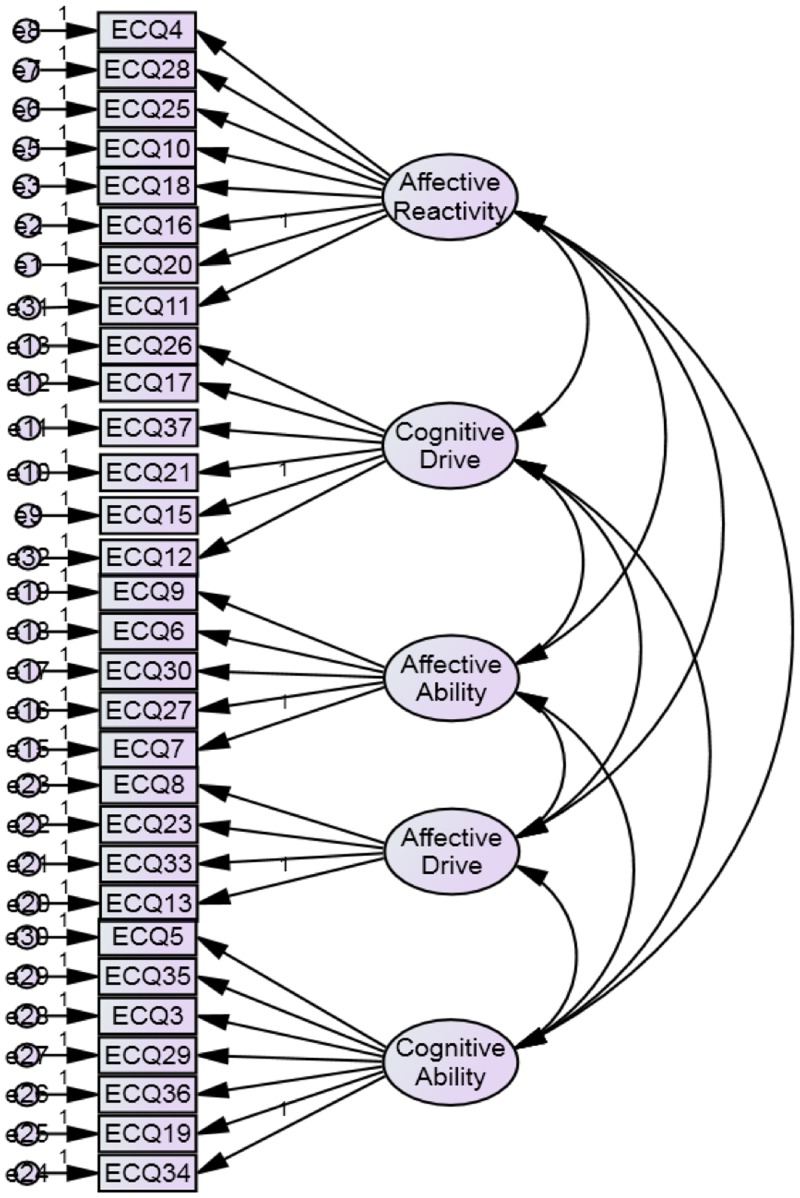
The hypothesized measurement model of the refined ECQ.